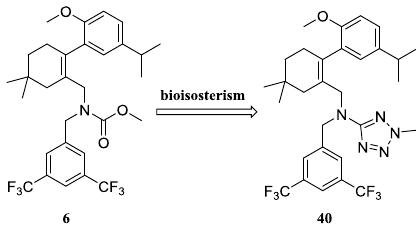
Figure 2. Design of new structures based on compound 6 .